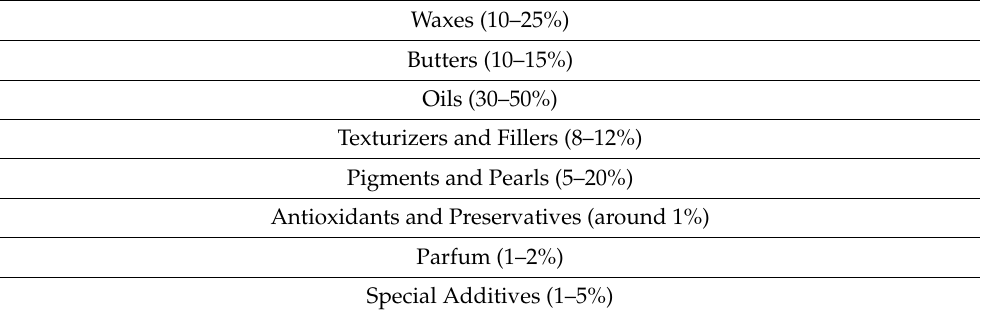
Table 1. Average composition of a lipstick formula, by